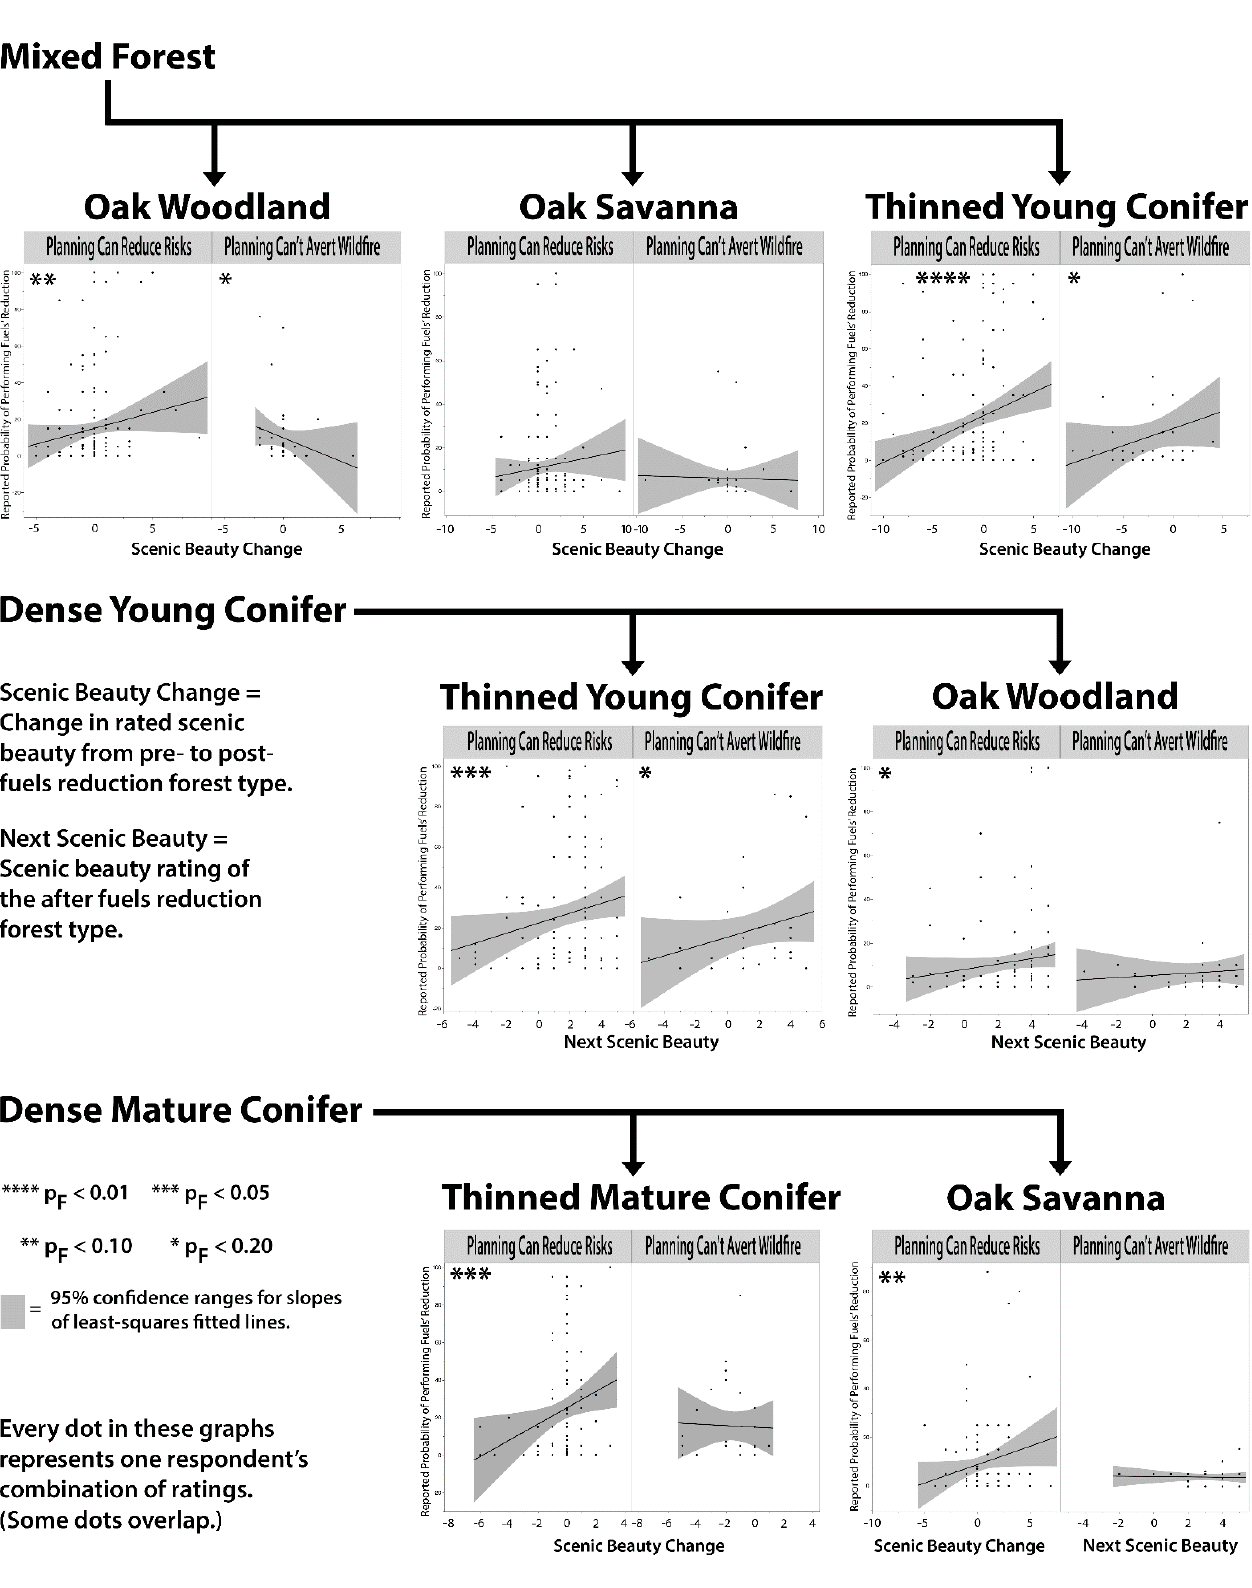
Figure 13. Attitudes toward planning against wildfire risk in relation to how scenic beauty perceptions correlate to fuels reduction propensities across all seven project types.